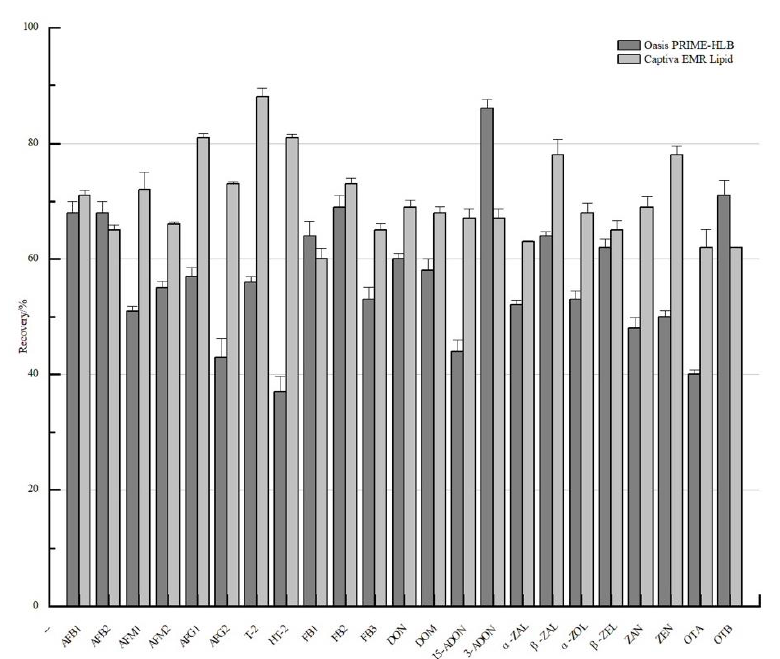
Figure 3. The influence of different purification columns on the recovery of each mycotoxin.